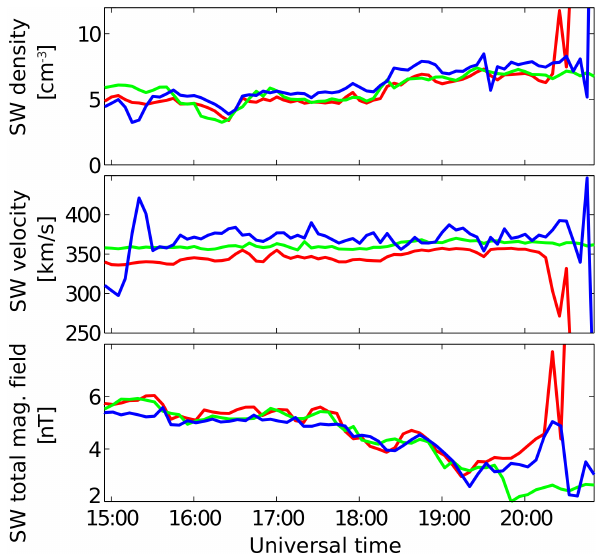
Figure 7. The reconstructed solar wind boundary conditions of the model density (top panel), the ion velocity (middle panel), and the magnetic field (bottom panel) for the magnetosheath data presented in Fig. 6 are shown in blue. Additionally, the THB (red) and OMNI (green) solar wind data during this time interval are